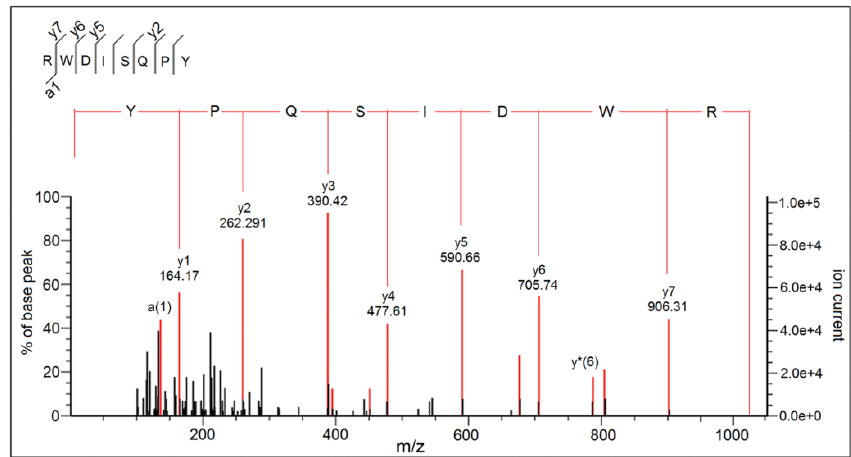
Figure 3. ESI-MS/MS spectrum of RWDISQPY identified in kernel expeller glutelin-2 hydrolysates. Figure 3. ESI-MS / MS spectrum of RWDISQPY identified in kernel expeller glutelin-2 hydrolysates. Nutrients 2020 , 12 , 653